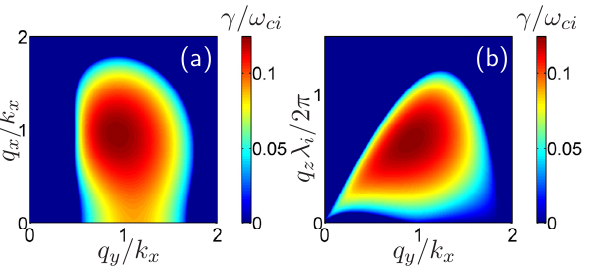
Fig. 1. The growth rate of the modified decay instability as a function of q . Panel (a) shows γ as a function of q ⊥ for q z = ( 2 π/λ i ) × 0 . 68. Panel (b) shows γ as a function of q y and q z for q x = k x .